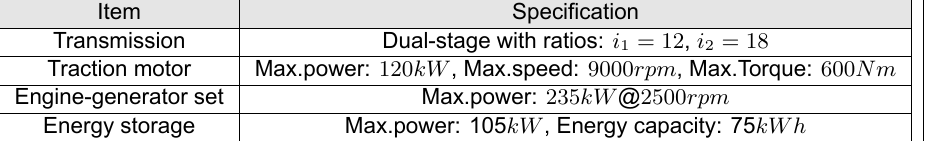
Table 2 – Overview of the powertrain specifications Таблица 2 – Обзор характеристик гибридного